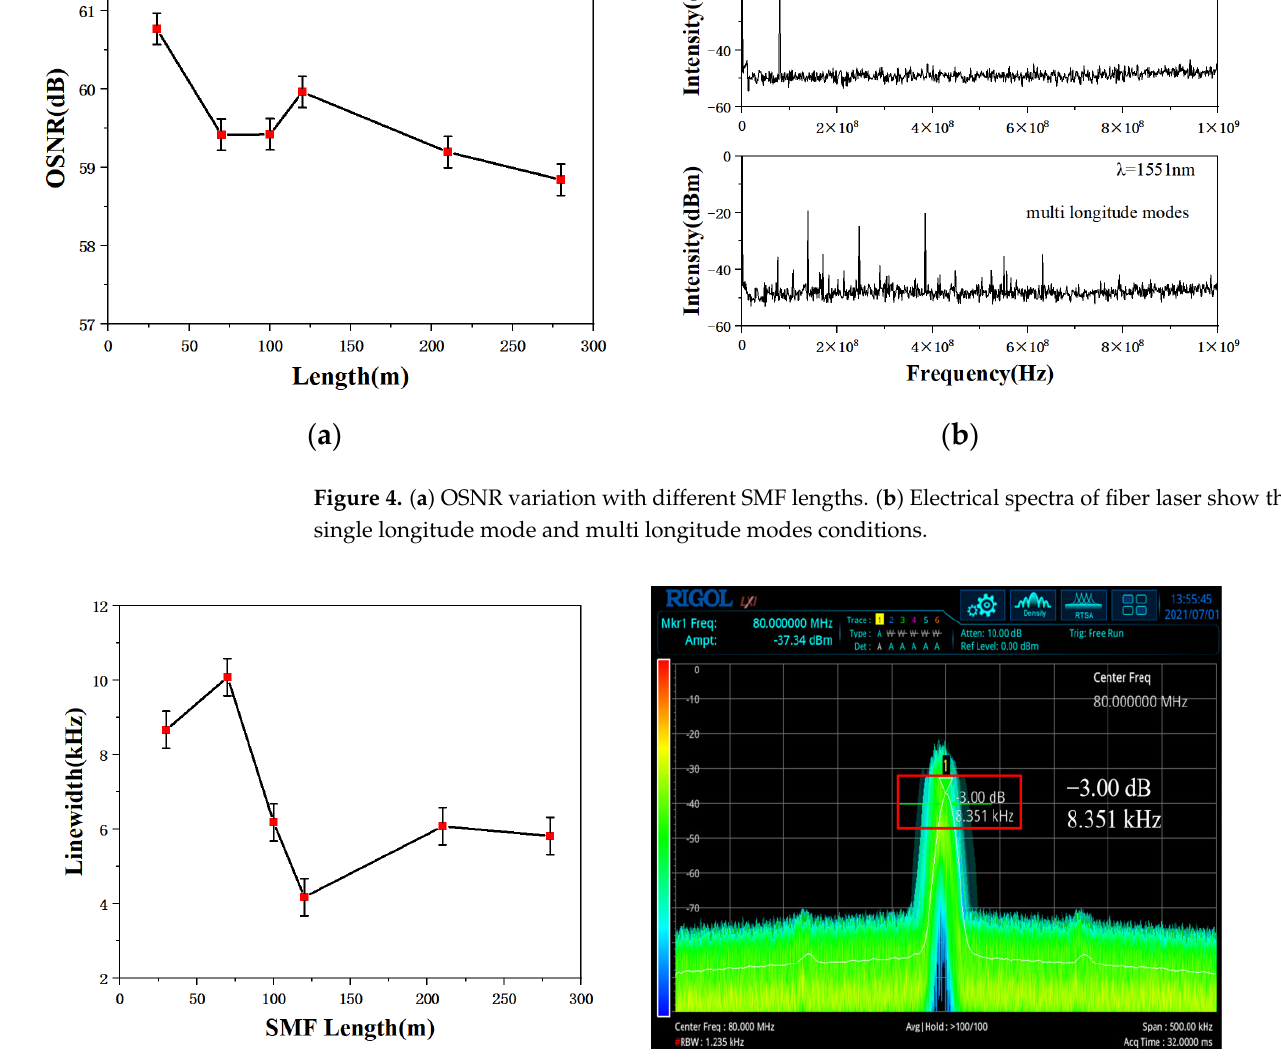
Figure 4. ( a ) OSNR variation with different SMF lengths. ( b ) Electrical spectra of fiber laser show the single longitude mode and multi longitude modes conditions.